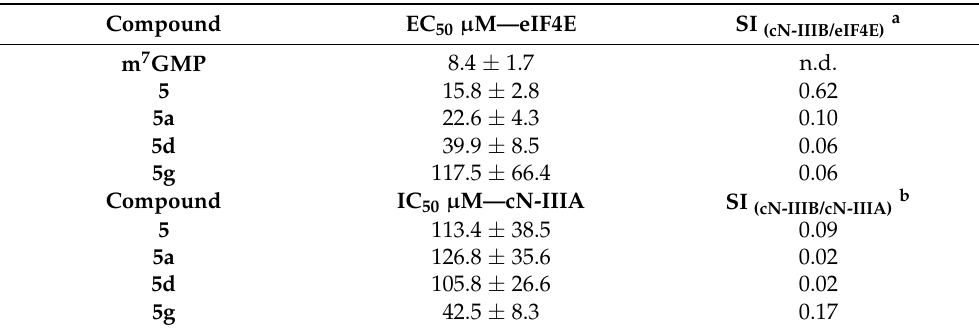
Table 2. Selectivity of second-generation inhibitors. The selectivity index towards weak binders of eIF4E (SI eIF4E) is expressed as a ratio of the IC 50 values for cN-IIIB to EC 50 values for eIF4E, while selectivity index towards weak inhibitors of human cN-IIIA is expressed as ratio of the IC 50 values for cN-IIIB to IC 50 values for